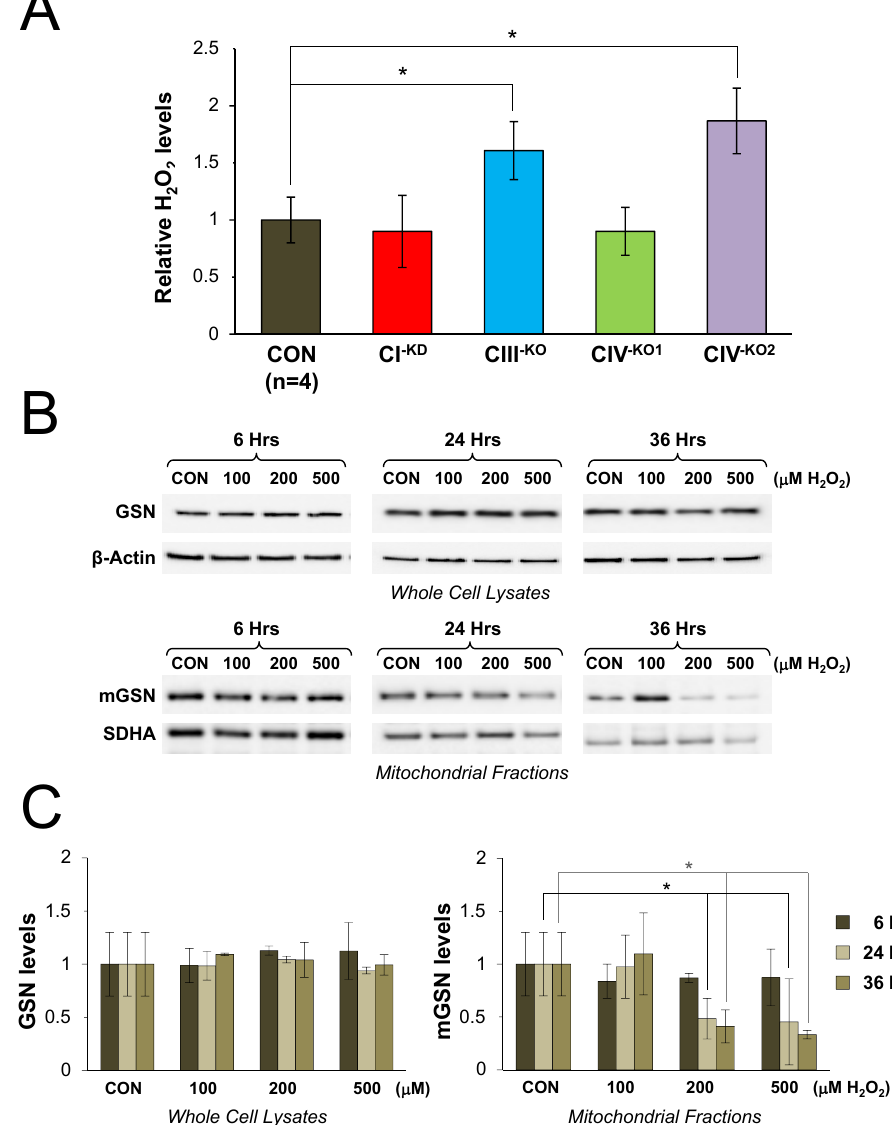
Figure 5. Oxidative stress does not trigger the upregulation and mitochondrial location of gelsolin. ( A ) Hydrogen peroxide levels in isogenic controls (CON, n = 4) and transmitochondrial mutant cybrids (CI − KD , CIII − KO , CIV1 − KO , and CIV2 − KO ). Values from eight independent experiments per cell line were normalized by the total protein amount per sample. Data are presented as the mean ± SD of each mutant cell line relative to the mean values of the four isogenic controls, set as 1. Mann–Whitney U test: * p < 0.05. ( B ) Control cybrids were cultured for 6, 24, and 36 h in the presence of 100, 200, and 500 µ M of hydrogen peroxide (H 2 O 2 ). In total, 15 µ g of whole-cell and mitochondrial protein extracts were separated on 10% SDS-PAGE gels and GSN levels were subsequently analyzed by Western blot, using β –actin as the loading control for the whole-cell lysates, and SDHA for the mitochondrial fractions. ( C ) The signals from four independent experiments were quantified and normalized by their respective loading controls. Data are presented as the mean ± SD relative to the untreated cells (CON) values, set as 1. Mann–Whitney U test: * p < 0.05. GSN, cytosolic GSN; mGSN, mitochondrial